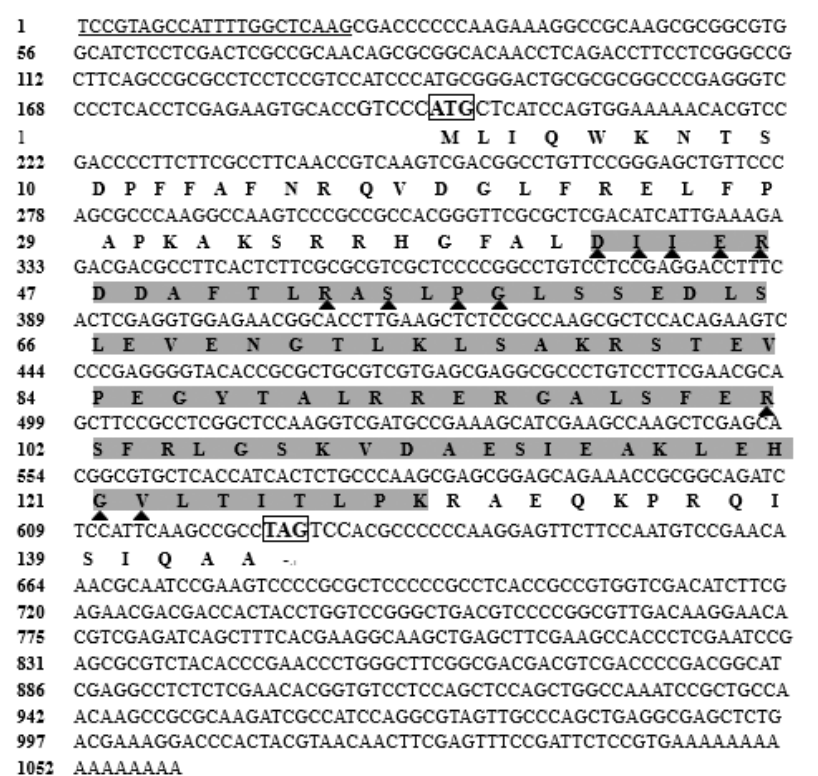
Figure 1. The cDNA and deduced amino acid sequences of StHsp20 (accession number: MN698834): the boxes for start and stop codons; underline for DinoSL; dark gray background for characteristic α -crystalline domain (ACD); triangles for the putative dimer interfaces.